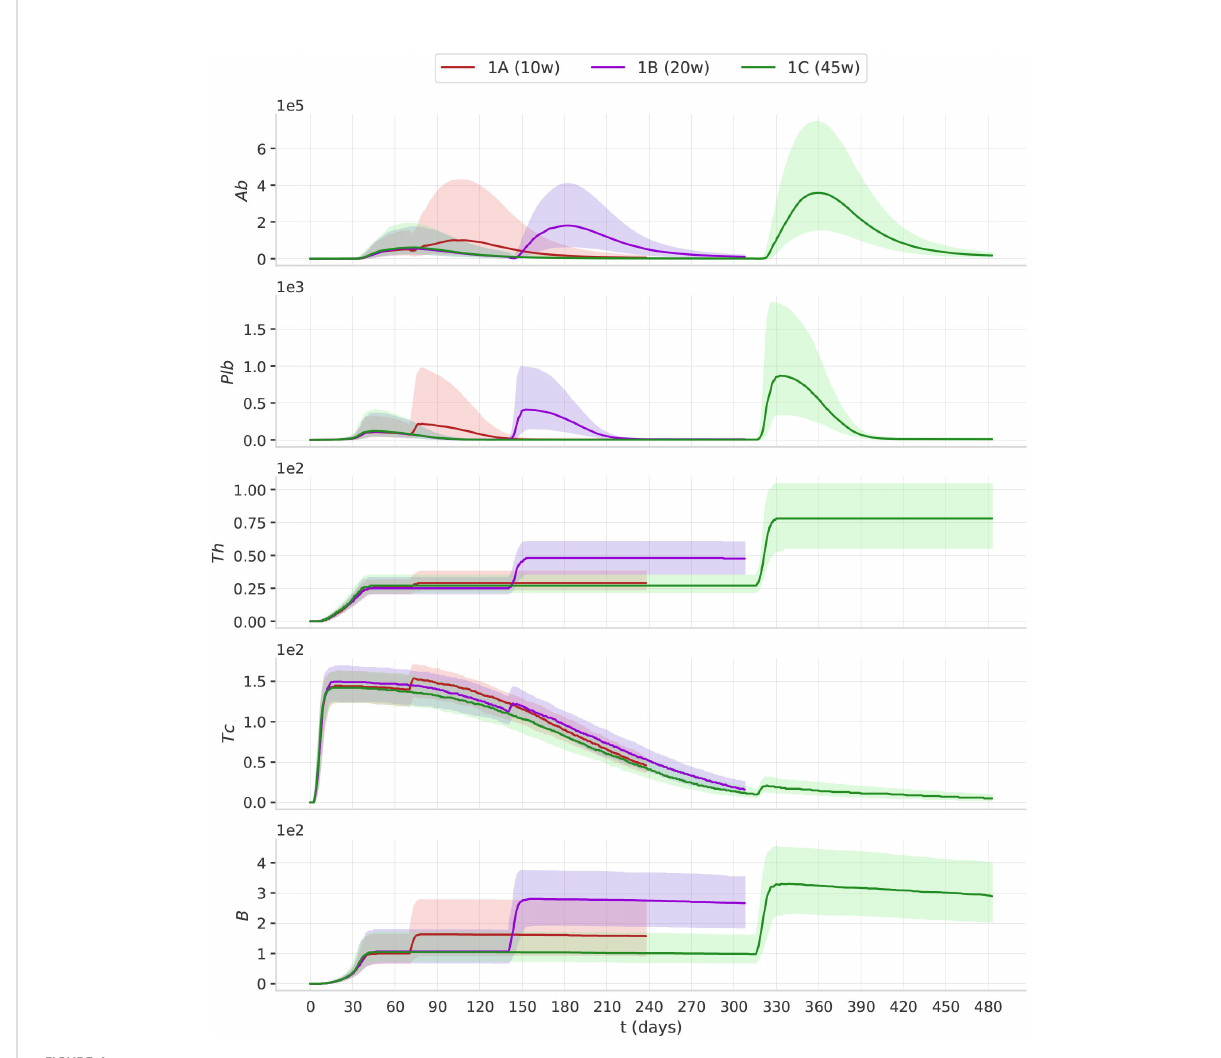
FIGURE 4 The timing of the second dose affects the dynamics of the immune response. The plots represent the median (solid lines) and IQR (shaded area) of Ab, Plb, Th, Tc, B. Protocols with longer intervals between the fi rst and second dose achieve higher antibody